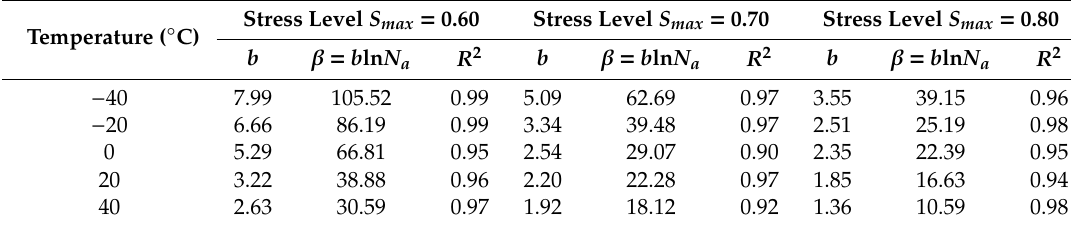
Table 10. The results of regression analysis of fatigue test according to Equation (3). Stress Level S max = 0.60 Temperature ( ◦ C)